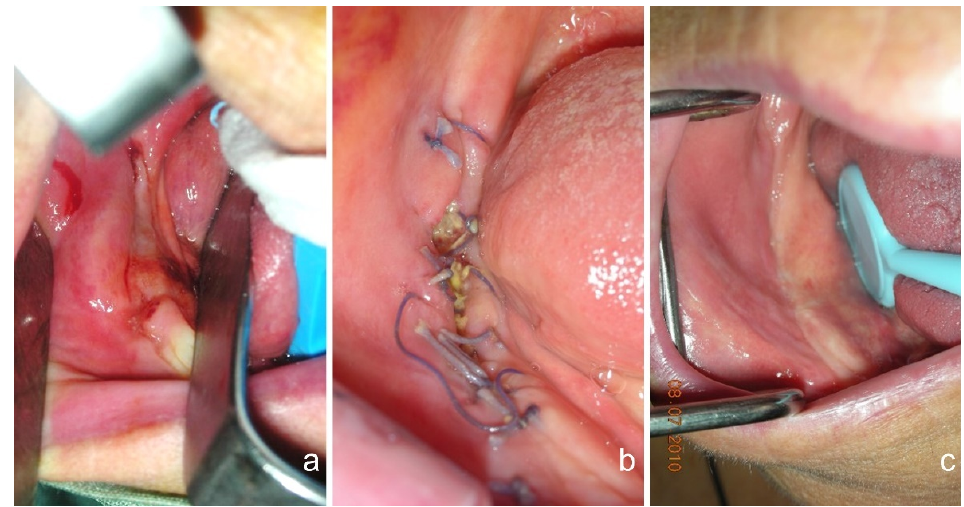
Figure 5. Clinical examination of a treated patient: ( a ) a fistula is present on the alveolar crest, through which the bone could be probed; ( b ) clinical control 7 days after surgery; ( c ) 6 months follow-up demonstrating the perfect healing of the musical lining. Table 3. Sequestrectomy with autologous fat graft and relative clinical trend after surgery.